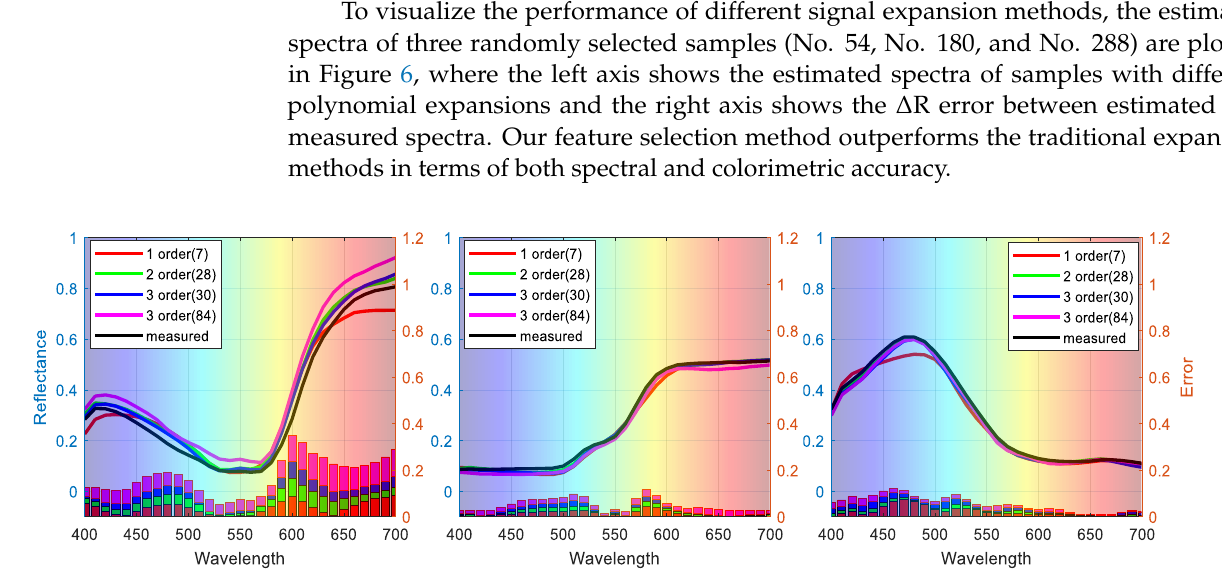
10 of 16 Table 1. Selected terms of the polynomial regression. Order Polynomial Regression 1st-order (6)